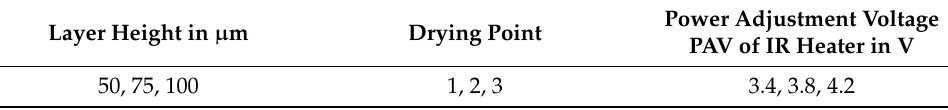
Table 2. Varied Parameters in the Coating